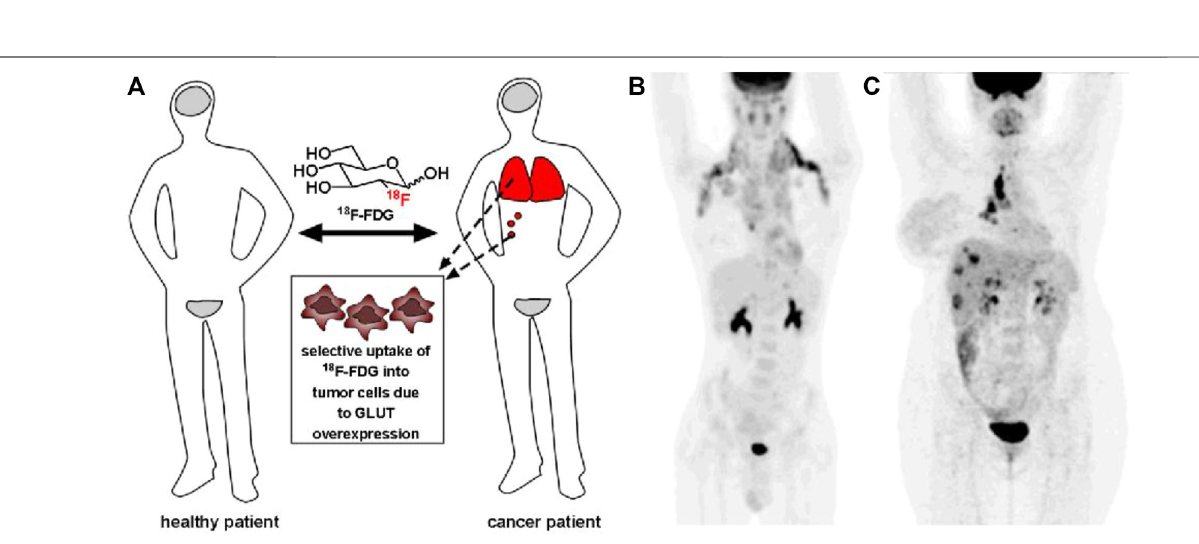
Frontiers in Pharmacology |